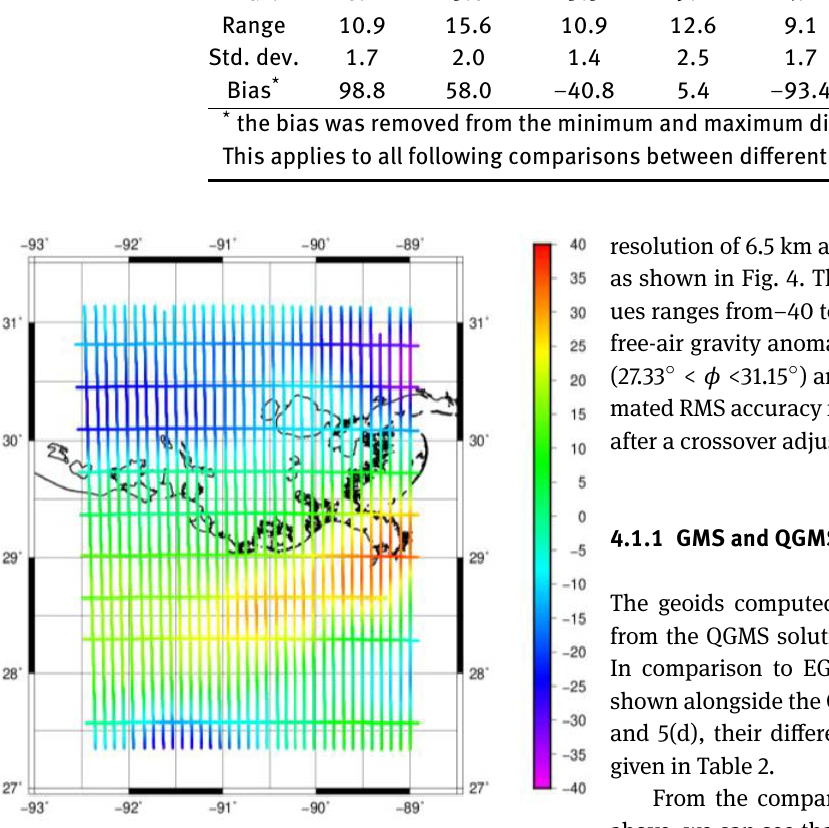
Figure 4: Observed free-air gravity anomalies in the Louisiana test area ranges from − 40 to 40